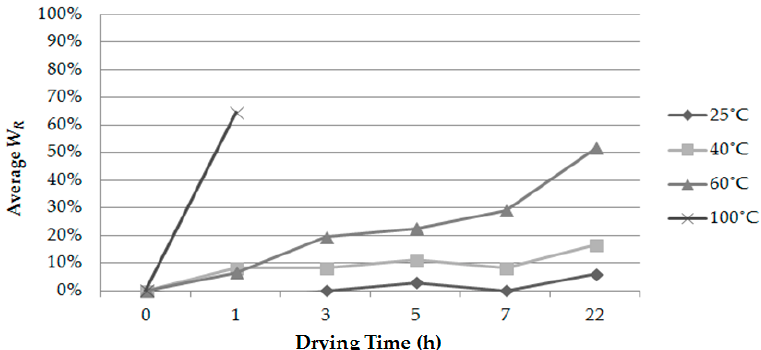
Figure 3. Average weight reduction rates of larvae of L. africanus after drying at 25, 40, 60 and 100 °C for 1, 3, 5, 7 and 22 h ( n = 3).